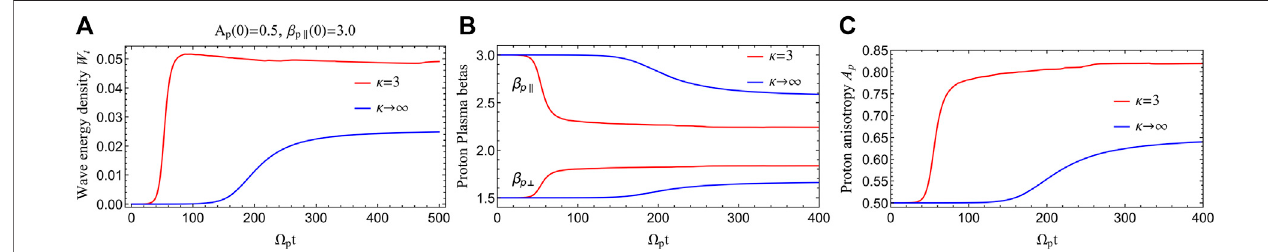
FIGURE 9 | Dynamical paths from QL theory, and the subsequent deeper relaxation of the anisotropy for bi-Kappa electrons (A) comparing to bi-Maxwellian limit (B) : the evolution of the anisotropy ( A p ) vs. parallel proton beta ( β p , (cid:3) ) triggered by the EMIC (top) and PFH (bottom) instabilities.